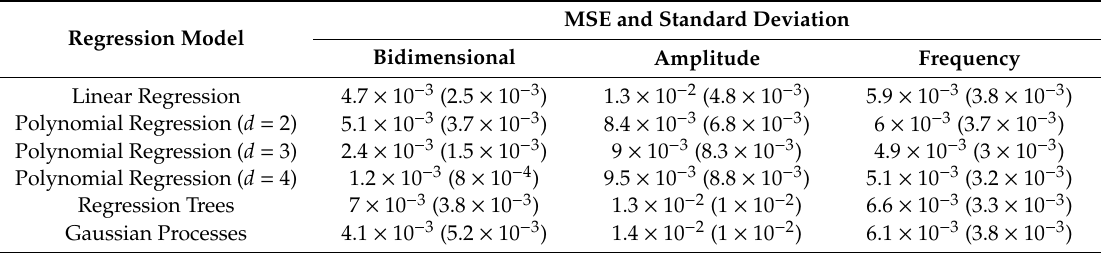
Table 3. Means and standard deviations of the MSEs using the di ff erent techniques, for